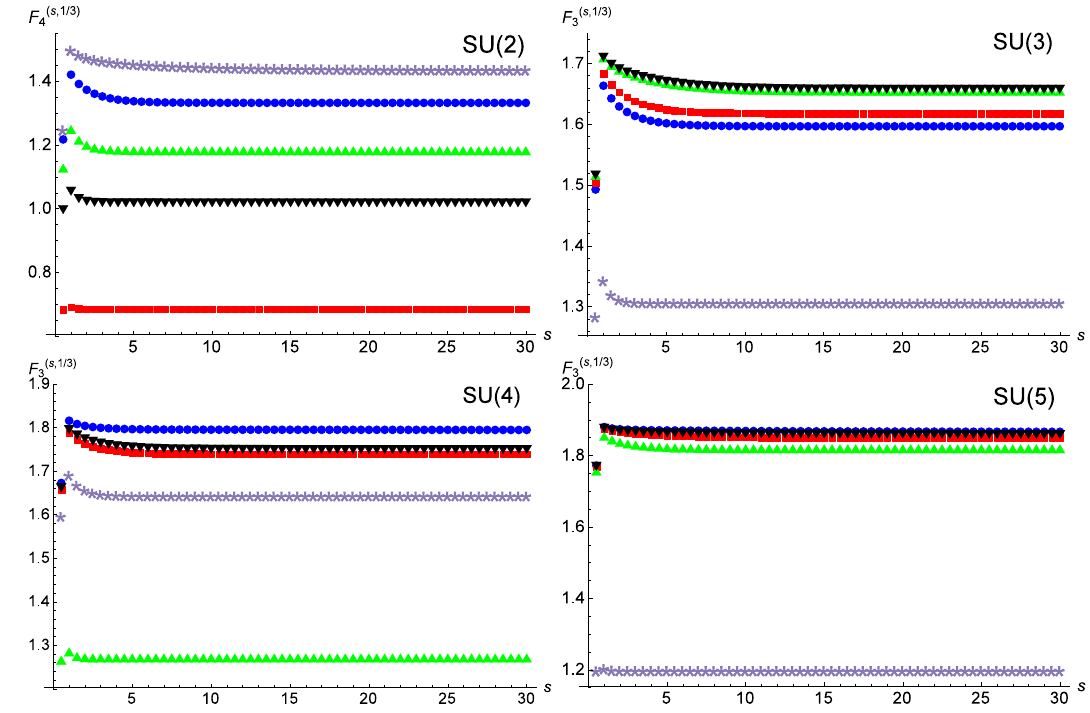
( (cid:28) ) of the 3